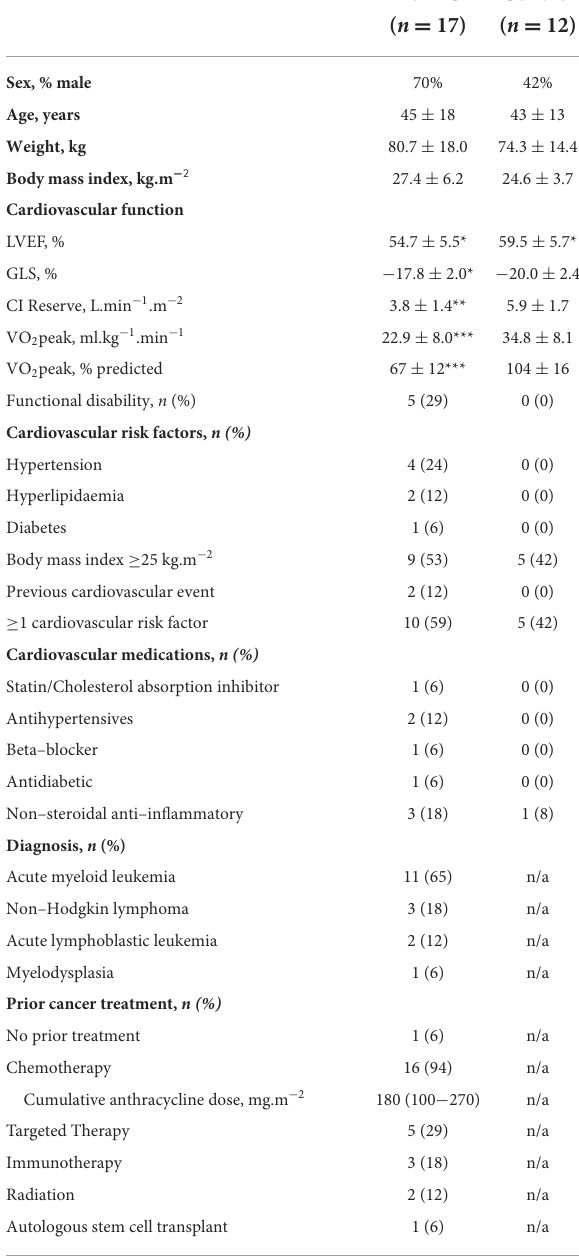
TABLE 1 Baseline characteristics for Allo-HCT and Control participants who completed baseline and follow-up assessments.